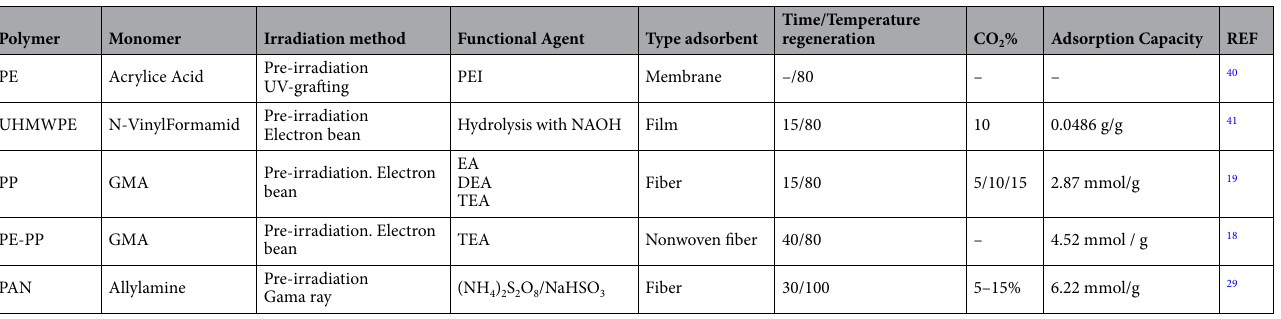
Table 3. Polymeric adsorbents for the removal of CO 2 gas.